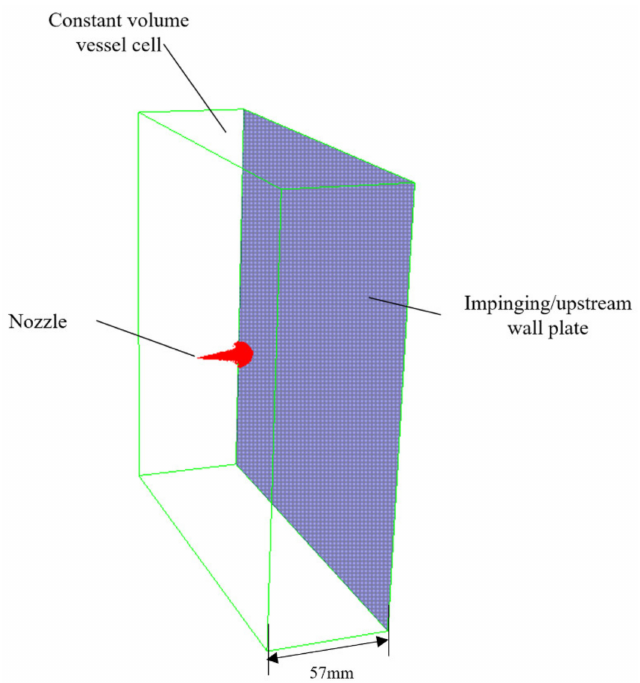
Figure 4. Concept diagram in the CFD simulation by using CONVERGE ™ .